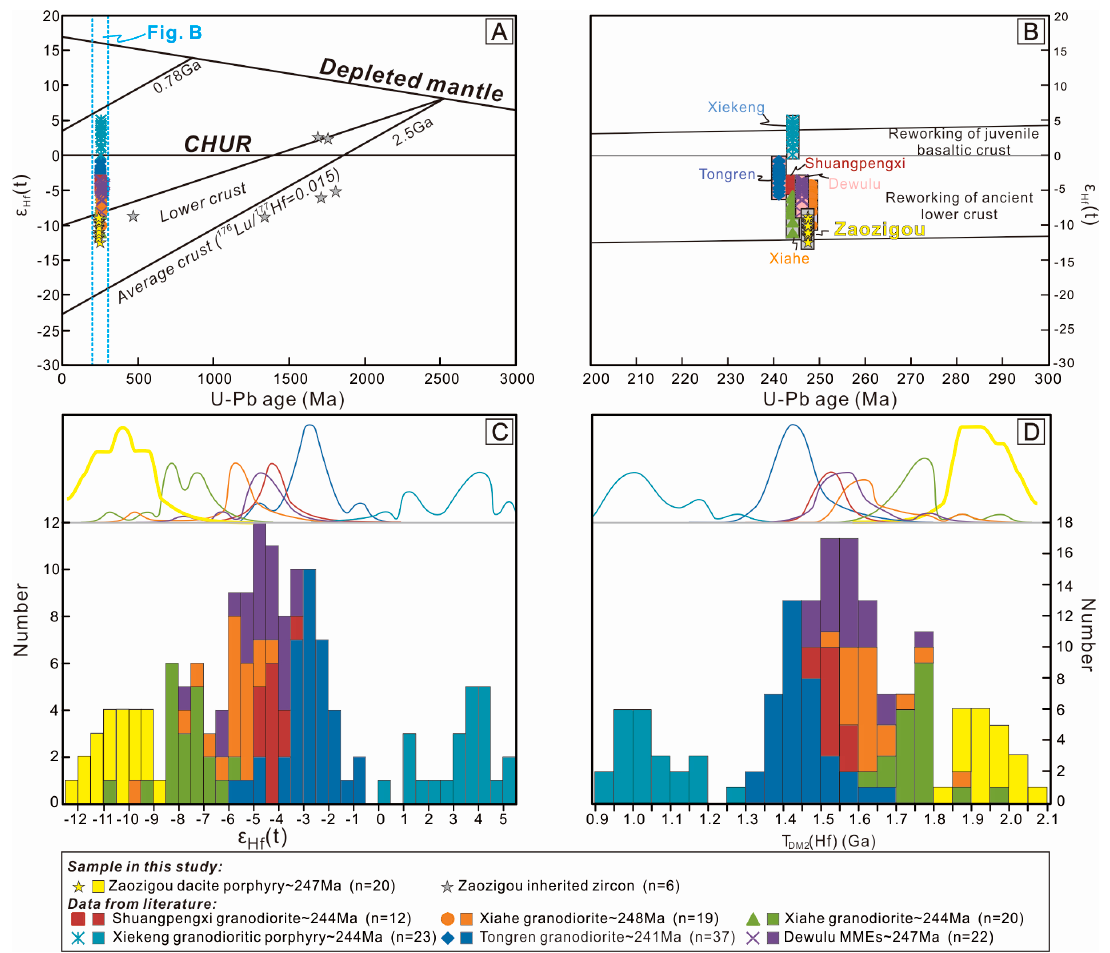
Figure 10. Variations of ε Hf (t) values versus U-Pb ages (Ma) of zircons from the Triassic granitoids in the Tongren–Xiahe–Hezuo area ( A , B ). ( C ) Histograms, and frequency curves of ε Hf (t) values. ( D ) Histograms, and frequency curves of corresponding two–stage Hf model ages (T DM2 ) (modified after [6]).